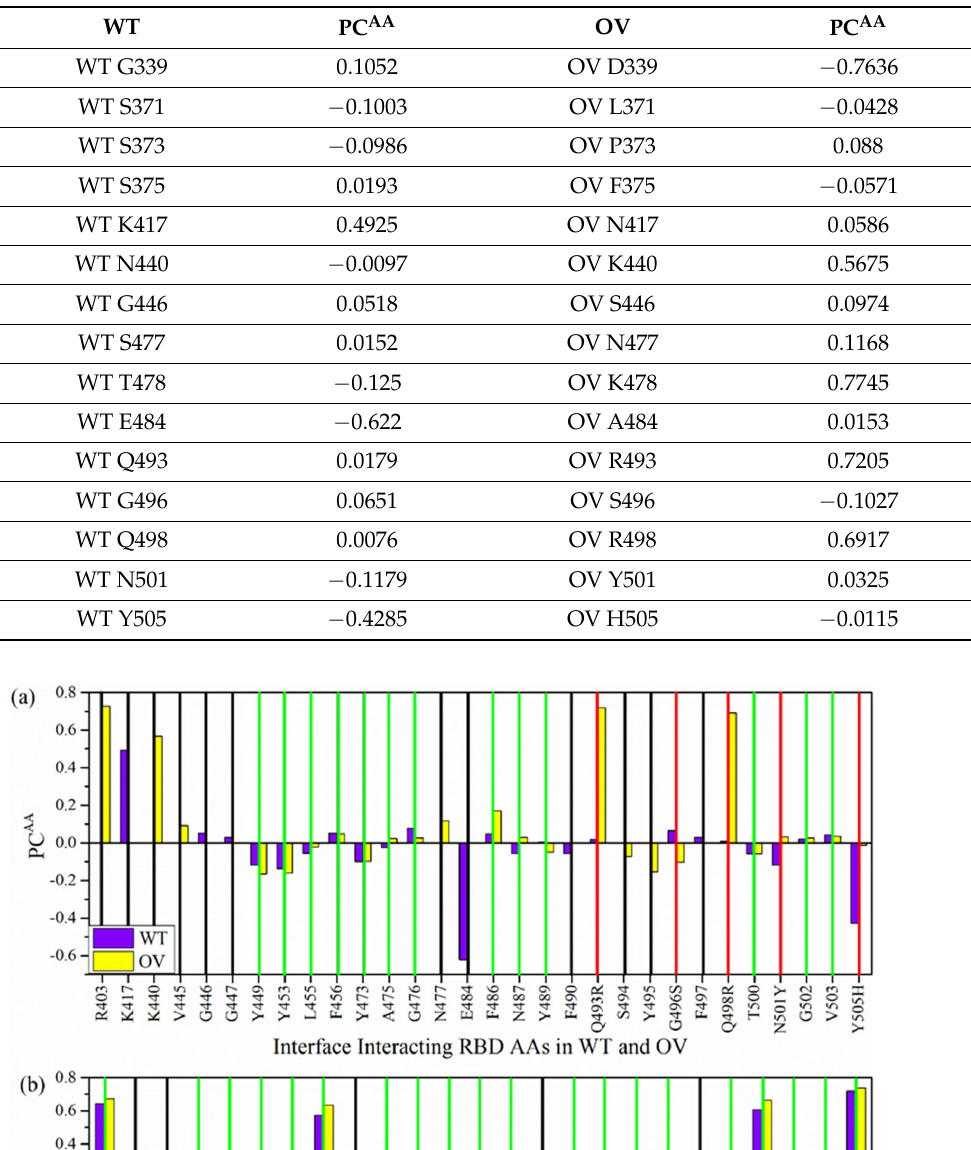
Table 3. Comparison of PC AA between WT and OV of RBD-ACE2.